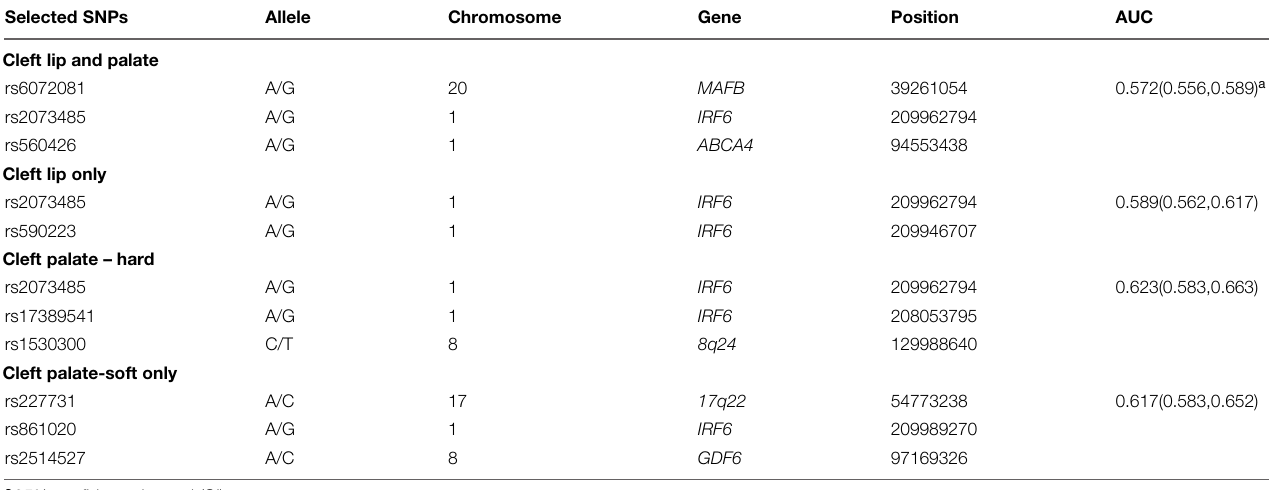
TABLE 2 | Risk prediction model for each sub-phenotype group of oral clefts.